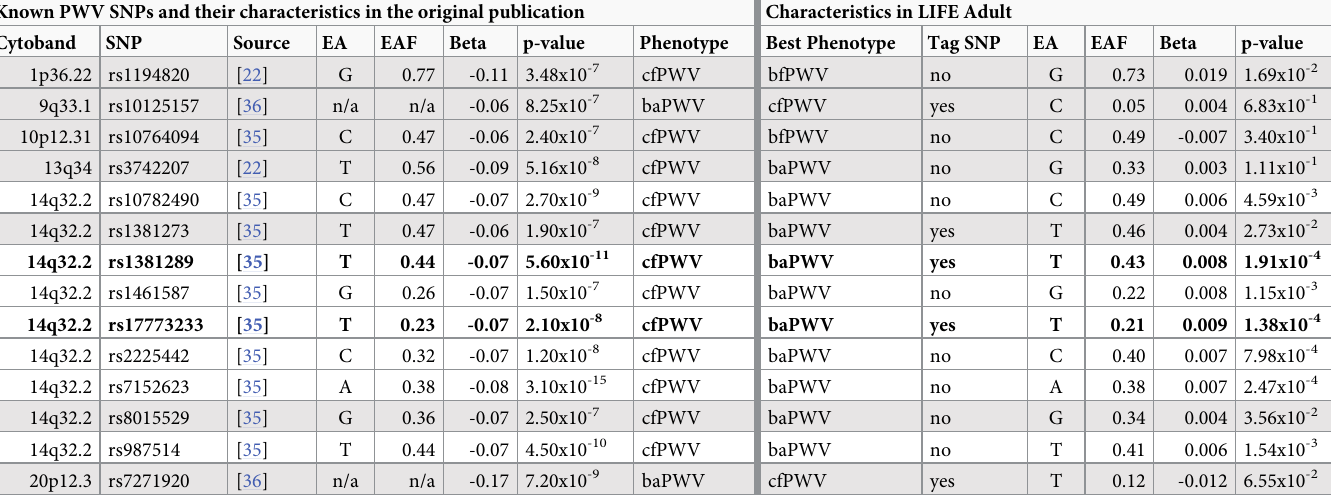
SNPs highlighted with grey back ground were not successfully replicated in our GWAS as they did not pass the Bonferroni corrected nominal significance level (p < 1.67x10 -2 ). SNPs in 14q32.2 are in LD with two independent lead SNPs (rs1381289 and rs17773233). Effect directions are opposite to Mitchell as he considered1000/ cfPWV as phenotype. Summary statistics of all SNPs and phenotypes can be found in S8